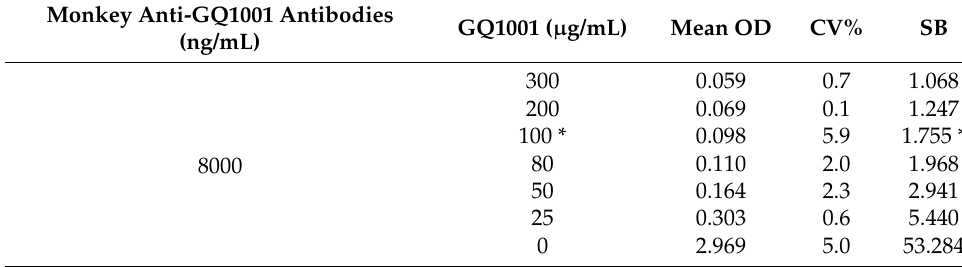
Table 3. Drug tolerance